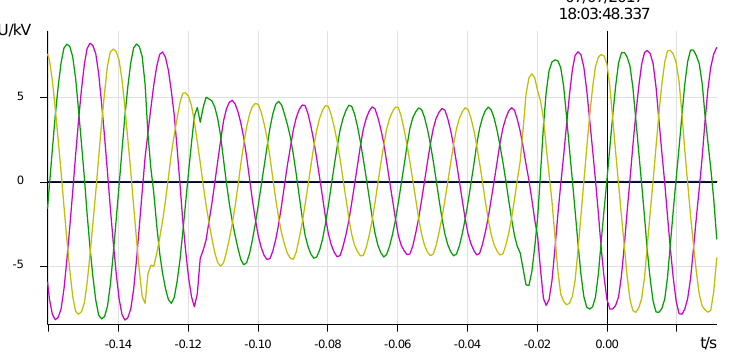
Figure 13. Waveform recorder from three-phase fault.